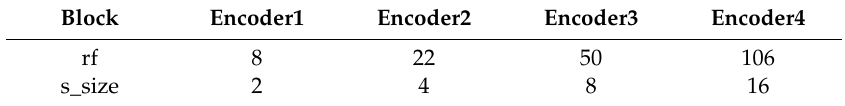
Table 2. The receptive field (rf) and stride size (s_size) in encoder module used in ECNet. Block Encoder1 Encoder2